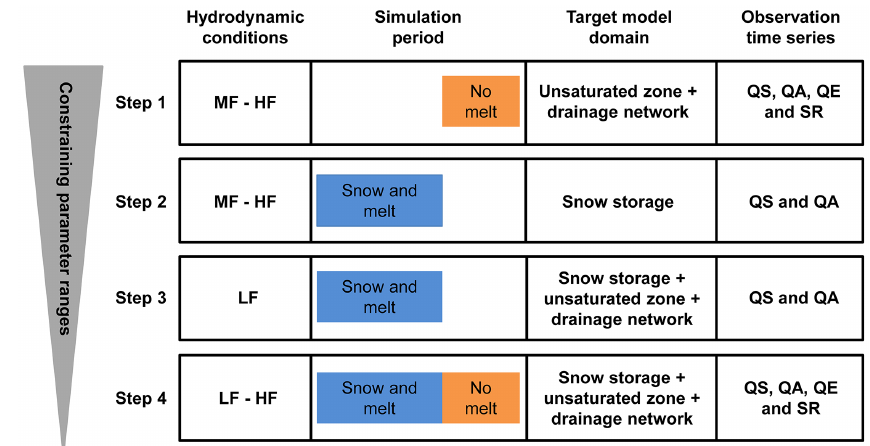
Figure 3. Strategy for the multi-step model calibration, where LF, MF and HF are for low-, medium- and high-flow conditions,